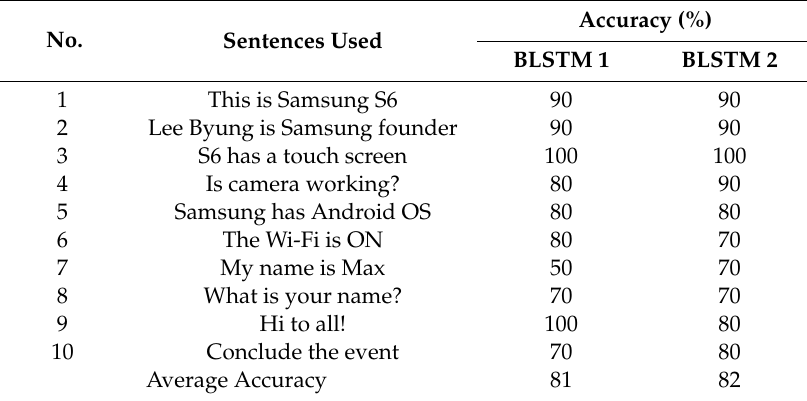
Table 2. Accuracy of BLSTM system.